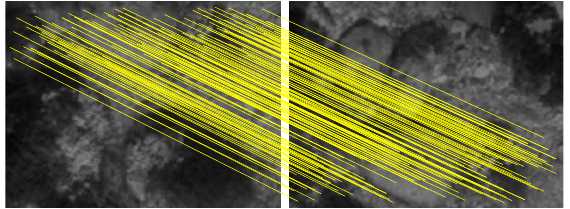
Figure 4. RANSAC underwater image registration using 2D